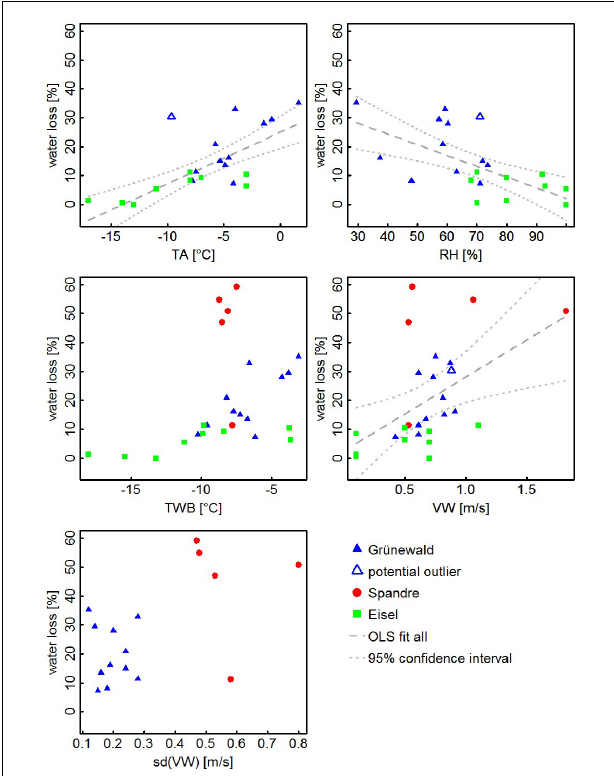
FIGURE 7 | Same as Figure 6 but data set was merged with data from Eisel et al. (1988) and Spandre et al. (2017).